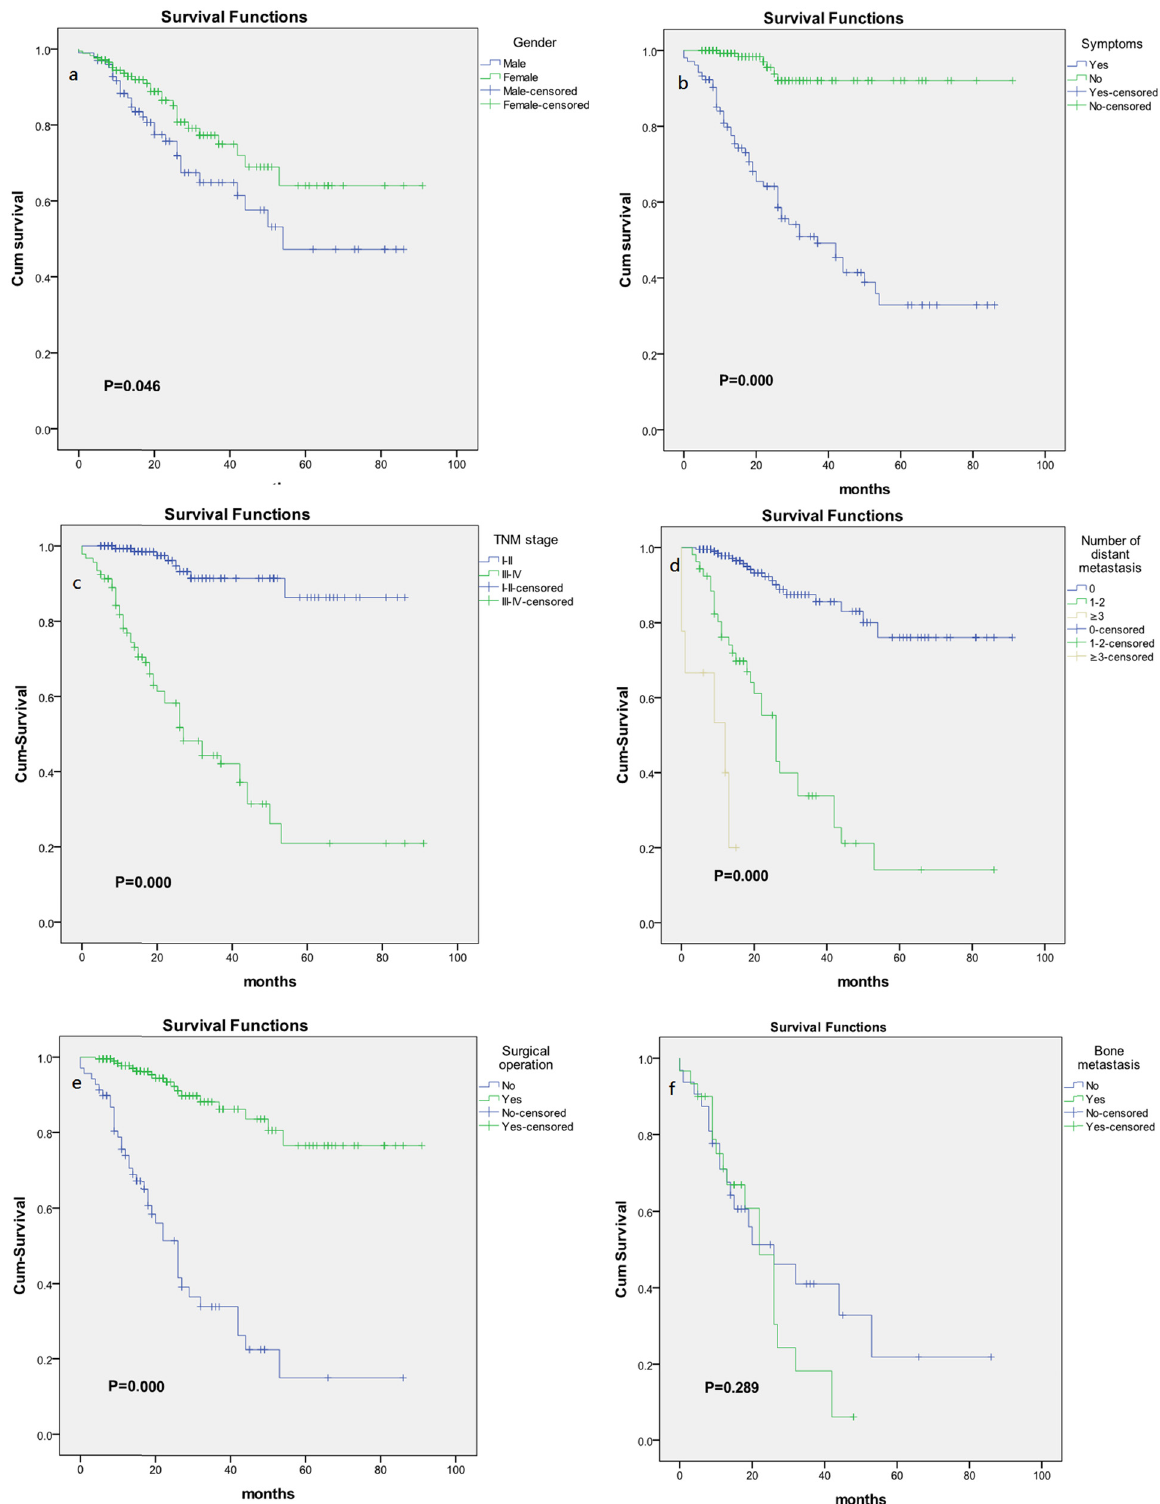
Figure 1: Survival curves in young patients of di ff erent groups: ( a ) di ff erent gender groups, ( b ) groups of symptomatic and asymptomatic, ( c ) groups of stage I – II and stage III – IV, ( d ) groups of di ff erent number of metastasis organs, ( e ) groups of surgery or not, and ( f ) groups of bone metastasis or not in stage IV